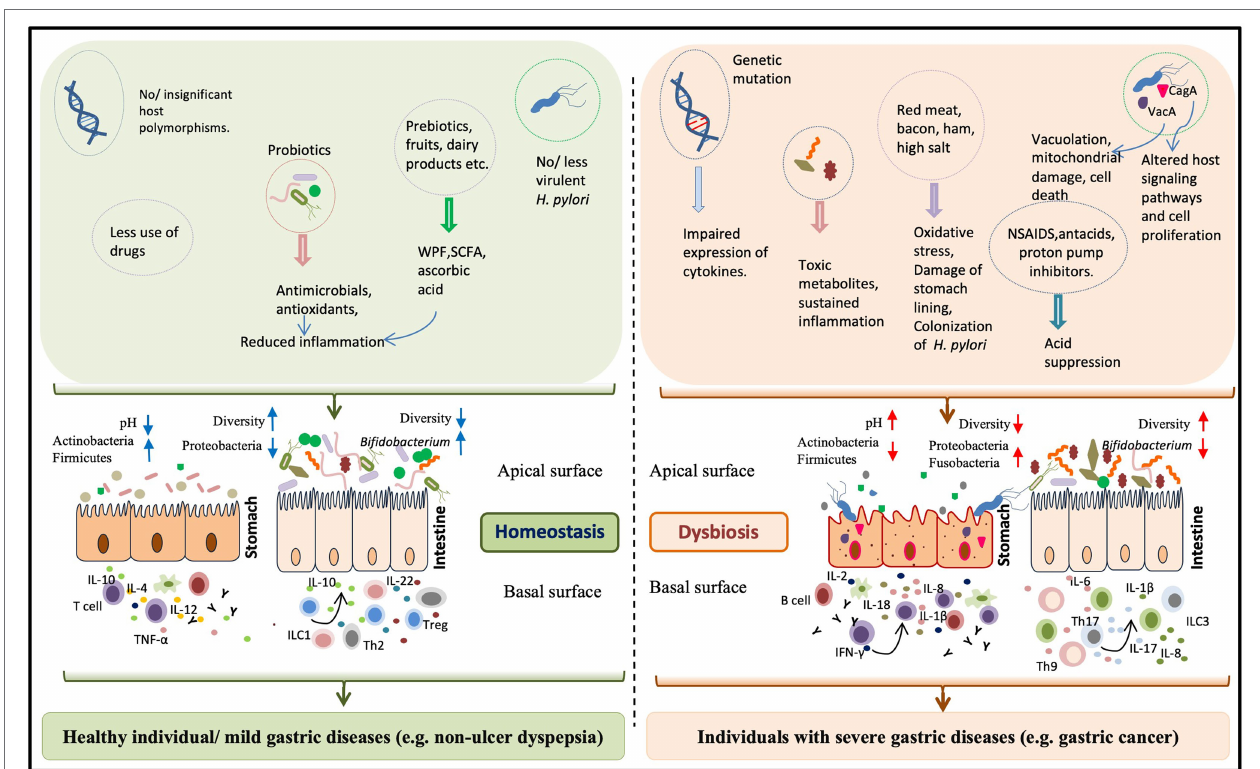
FIGURE 1 | The impact of “ H. pylori factors” and “other factors” on the gastric health and diseases. The gastric health is determined by the combination of microbial, host, and environmental factors. Normally gastric inflammation remains under control by the constant interaction between the inhabiting microbes and the host immune system. The beneficial microbes in the form of probiotics (producing antimicrobials and anti-oxidants) or in ingested ethnic fermented foods and the prebiotics play major roles in maintaining the homeostasis within the gastric milieu. For a healthy stomach, where the pH is low, the colonization is restricted to microbial phyla like Actinobacteria and Firmicutes. But, the long term colonization of H. pylori , apart from creating gastric damages due to its virulence factors like vacuolating cytotoxin A (VacA) and CagA, also leads to the loss ofgastric parietal cells and the gastric pH increases. In the altered gastric pH, several harmful bacteria (e.g., several members of the phylum Proteobacteria) become predominant. Several other factors have the potentials to disturb the gastric homeostasis. For instance, impaired expression of host immune regulators, increased consumption of red meat, and excessive use of non-steroidal anti-inflammatory drug (NSAID) and acid suppressors can enhance the pro-inflammatory response. Dysbiosis of the intestinal microbiota, particularly lower abundance of Bifidobacterium species has recently been linked to the H. pylori associated severe gastric